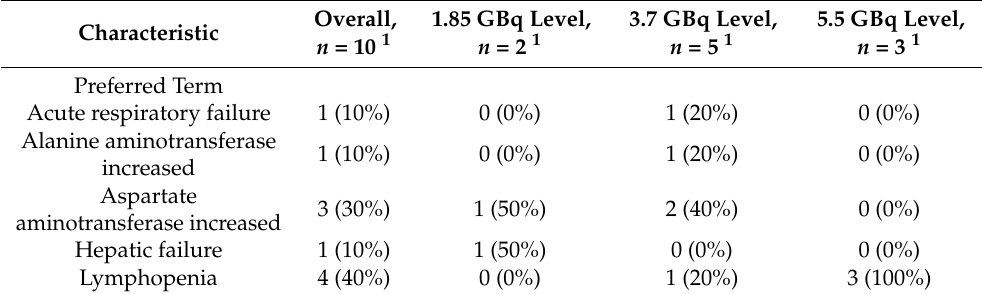
Table 3. Related adverse events of Grade ≥ 3 according to the activity